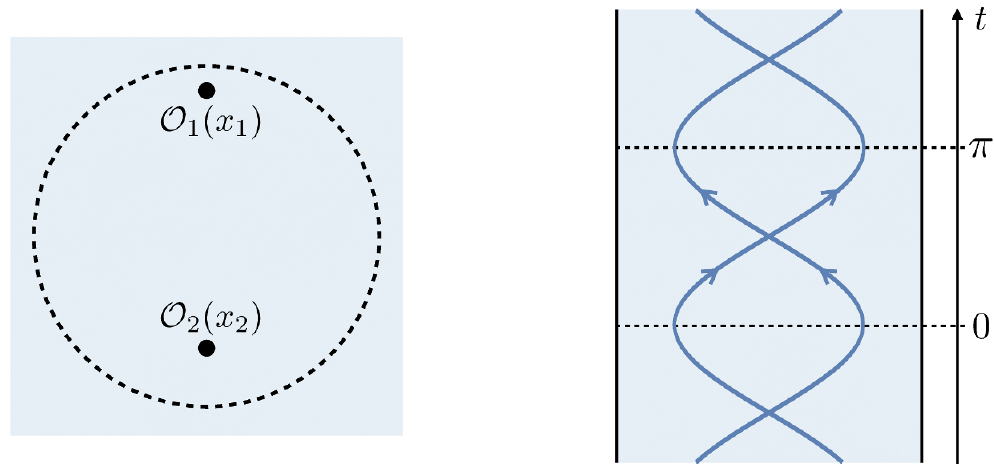
Figure 3 . On the left, we show the euclidean preparation of the two particle scattering state by the insertion of O 1 and O 2 inside the unit sphere. Projecting onto primaries of spin l and dimension (cid:1) 2 ] E (cid:0) 1 ; E + 1] and taking the limit x 2 ! 1 we obtain the state j (cid:9) l ( E ) i . On the right, we depict the Lorentzian evolution of this state starting from t = 0. The blue lines indicate timelike geodesics that represent the classical evolution of two massive particles in AdS in the center of mass